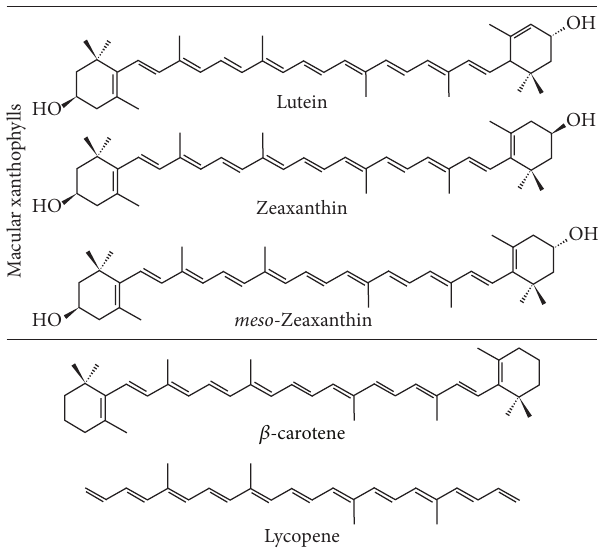
Figure3:Structuresoflutein,zeaxanthin,B-carotene,andlycopene.